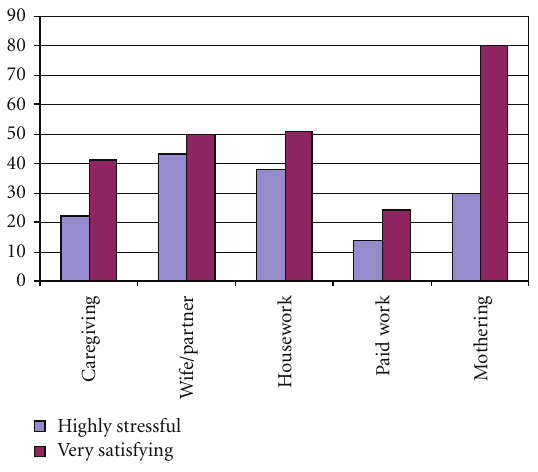
Figure 1: Results of WRIP-Modified ( n =